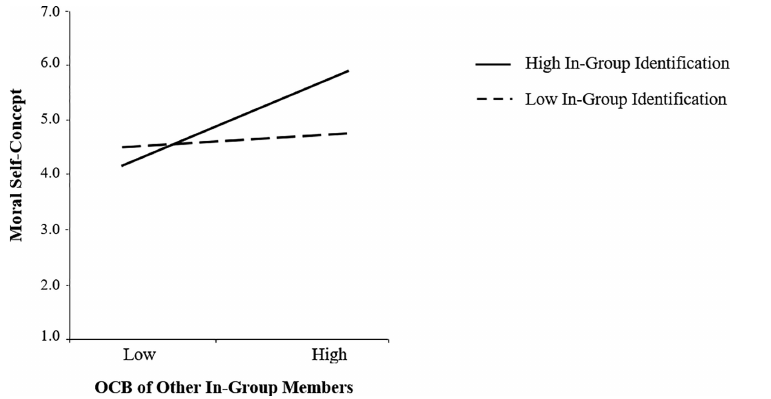
Figure 2. Relationship between other in-group members ’ OCB and moral self-concept as a function of in-group